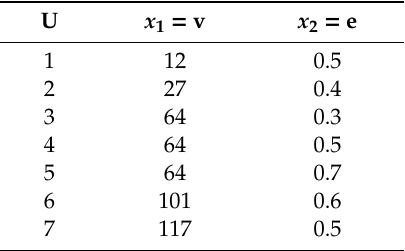
Table 3. Real values of the variables according to experiment